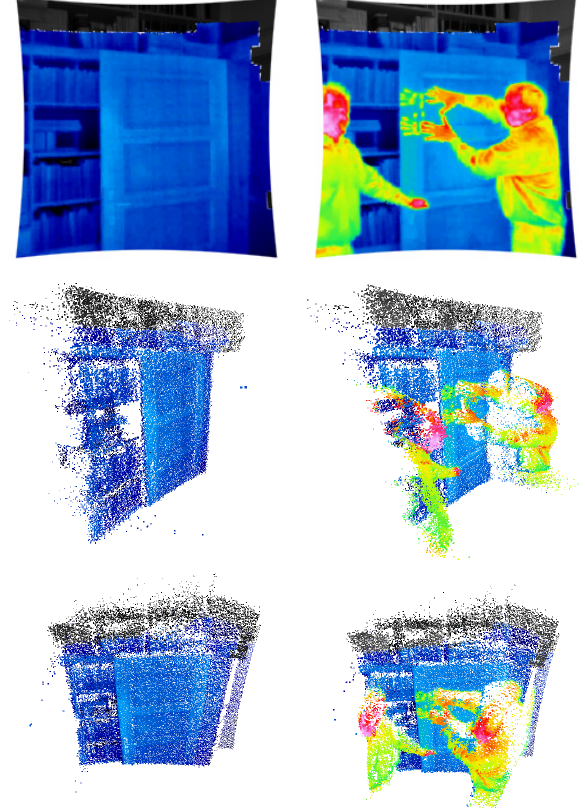
Figure 10: Sensor platform equipped with a range camera (left) and a thermal camera (right).